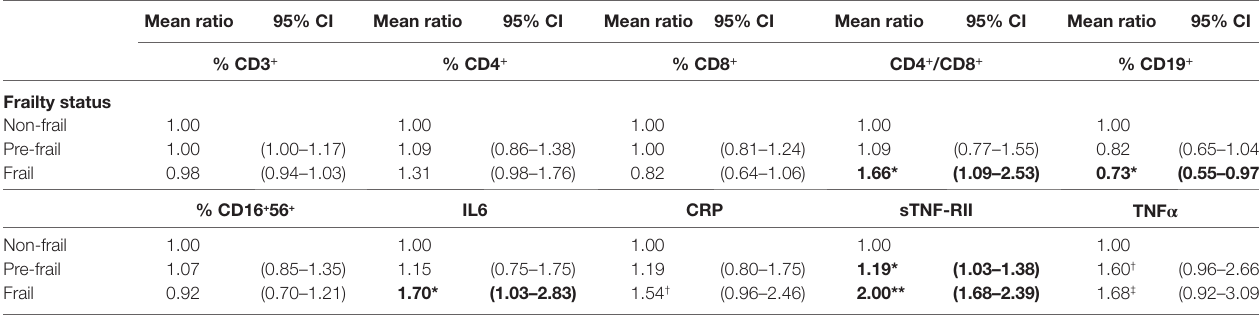
Table 3 | Effect of frailty status on lymphocyte subsets and inflammatory mediators; models adjusted by age, sex, smoking habit, and comorbidity.